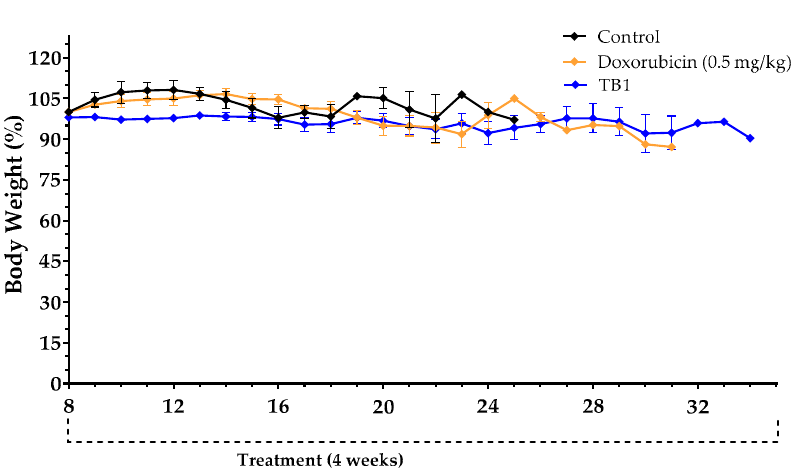
Figure 3. Anticancer effect of diet TB1 and doxorubicin in mice with TNBC (4T1 murine breast cancer cells inoculated in the tail vein of immunocompetent BALB/c mice). Survival ( a ) and body weight ( b ) of mice treated with doxorubicin (0.5 mg/kg/day, every week for a total of 4 doses), with diet TB1 (normal diet was replaced by TB1 for 28 days) or untreated mice (control, normal diet). Treatments began 8 days after the intravenous injection of 100,000 4T1 cancer cells. Body weight are expressed as percentage relative to the body weight at the beginning of the treatments (day 8). Data are from three independent experiments. The four mice fed diet TB1 that lived longer are from two independent experiments.